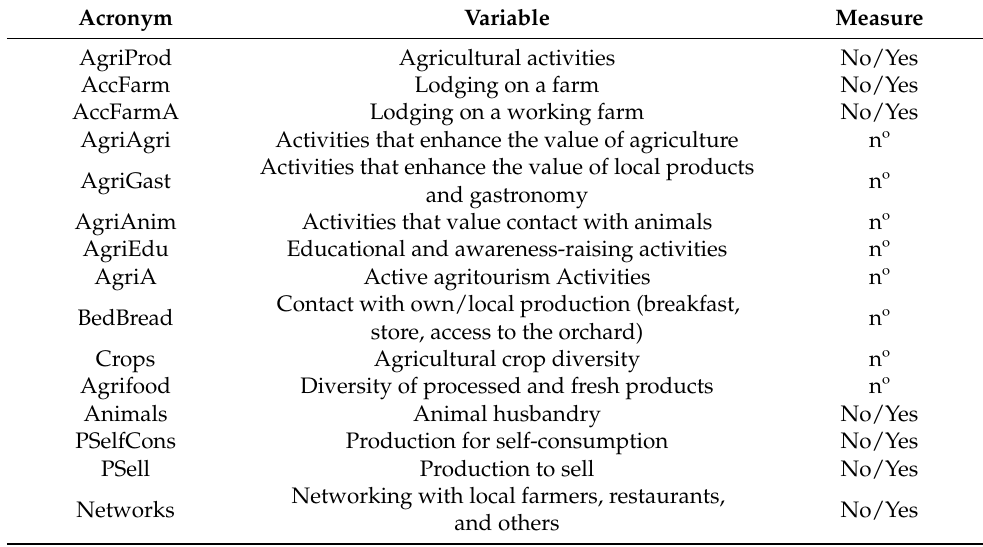
Table 2. Variables applied in the clustering analysis